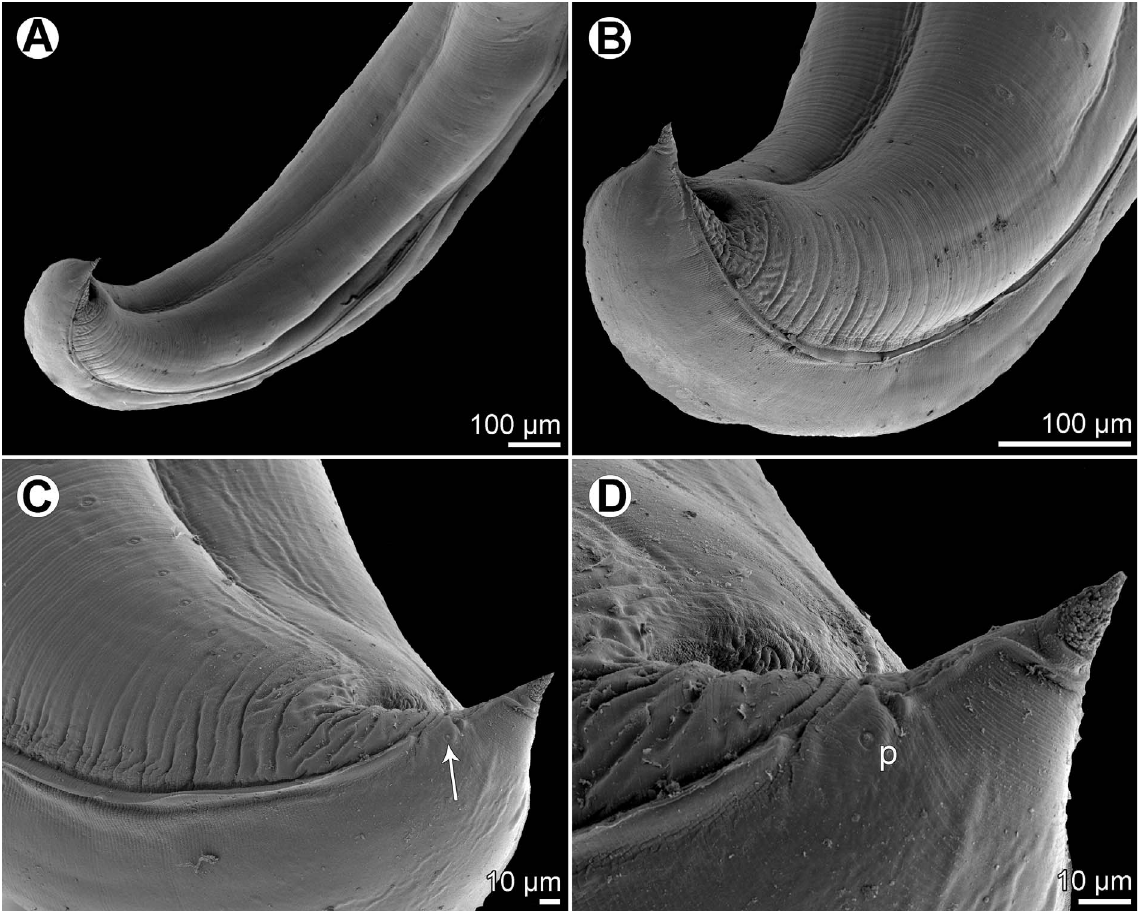
Figure 17. Hysterothylacium epinepheli (Yamaguti, 1941), scanning electron micrographs of male. (A) Posterior end of body, ventrolateral view; (B) enlarged posterior end, ventrolateral view; (C) same from opposite side (arrow indicates phasmid); (D) tail, lateral view. (p)